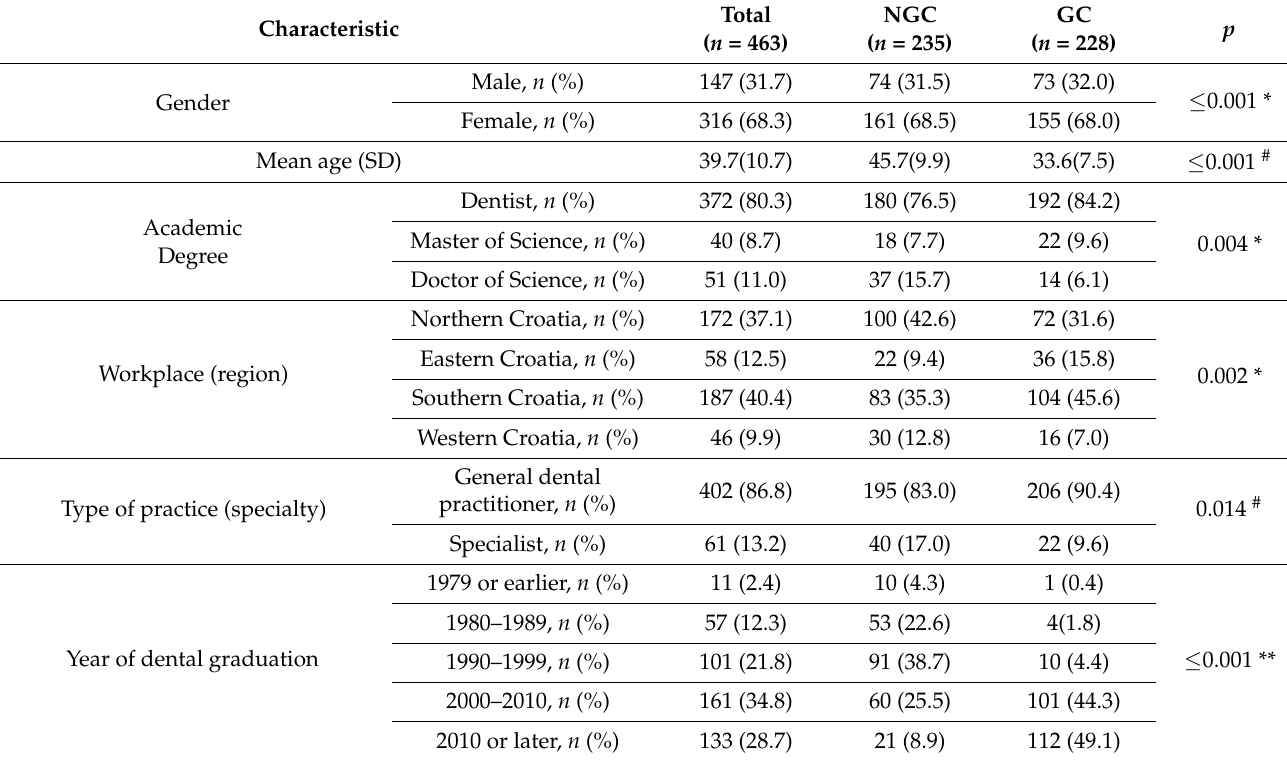
Table 1. Personal and professional data of the